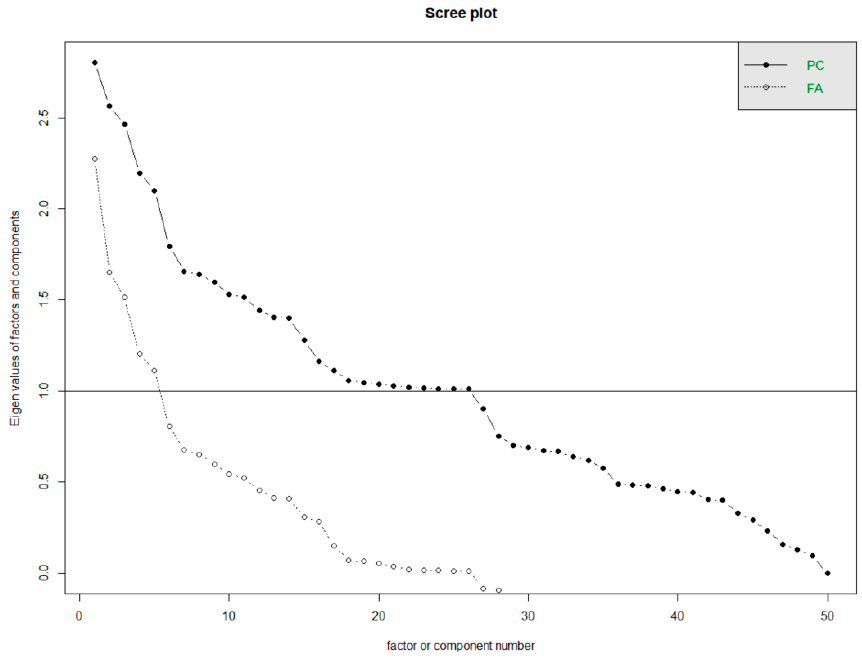
Figure 8. Scree plot indicating the number of correlated factors for movies in China. Table 6. The structure of movie title keywords resulting from the factor analysis (China). Factor Movie Title Keyword